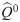
Network of interacting neural populations.A Schematic diagram of the ND model: the neural populations (purple circles) receive noisy inputs as well as recurrent feedback (gray and red connections, respectively). The topology is non-random: 2 groups of interconnected populations (green dashed boxes) are linked by hubs (cyan dashed box), but the hubs are not connected to each other. B Connectivity matrix C for a network of 50 populations, corresponding to the strengths of the red connections in A. The indices for the two groups are indicated by the green bars, and hubs by the cyan bar. C Example time series between two populations in the network, one from the large group in A and a hub. In the right panel, the darker curve is shifted by τ = 1 s. D Empirical covariance matrices between all neural populations, evaluated from the time series in C with the two time shifts: τ = 0 for Q^0 and τ = 1 s for Q^τ; see expression for Qτ in Eq (2). The color scale is adjusted to focus on off-diagonal elements. E Logarithm of autocovariance Q^iiτ for each node i as a function of τ. The mean over all nodes (blue curve) has a slope close to 1/τx (black line). F Asymmetry of theoretical Qτ as a function of the asymmetry of C. The asymmetry index in Eq (24) scales from 0 for symmetric to 1 for antisymmetric matrices. Three time shifts τ are displayed (lighter to darker blue), each cross represents a cluster-hub network similar to A and the corresponding line indicates the linear fit. G Network effect indicated by the weak match between C weights and Q0 values over all connections. H Schematic representation of a step in the Lyapunov optimization (LO) procedure. The model covariances Q0,τ are evaluated for the current network parameters C and Σ. From the comparison between the model Qτ/0 and their objective counterparts Q^τ/0, the desired updates ΔC and ΔΣ for the model parameters are calculated.